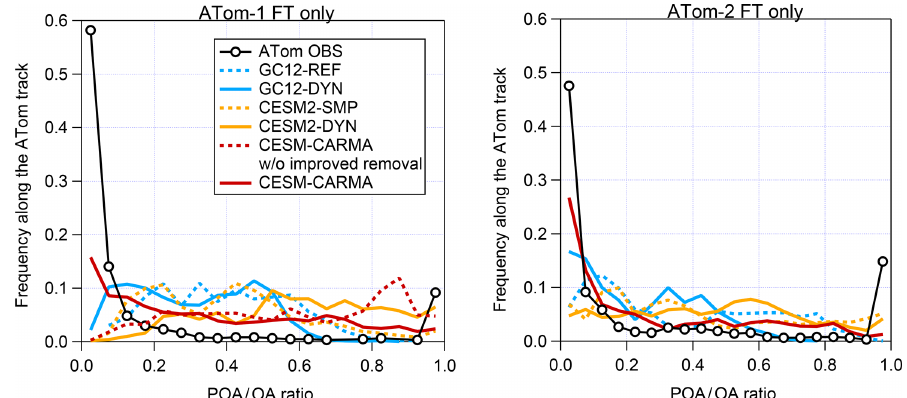
Figure 7. Frequency distribution of the observed and simulated ratio of POA to total OA in the free troposphere during ATom-1 and ATom-2 as computed by the GC12, CESM2, and CESM1-CARMA